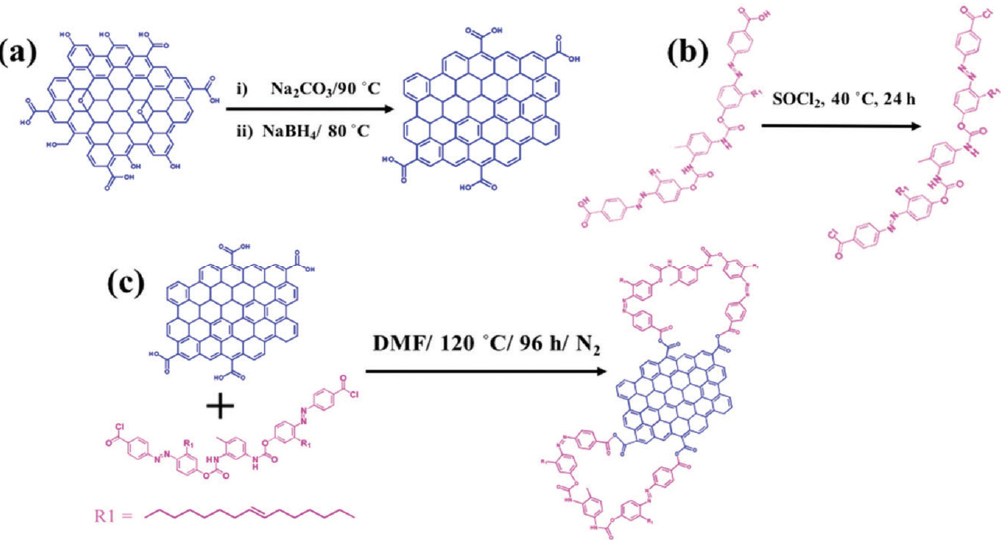
Figure 16. ( a ) Preparation of RGO, ( b ) conversion of AZOC2 to acid chloride, and ( c ) synthesis of the covalent RGO–AZOC2 hybrid (RGO–AZOC2-C). (Reprinted from [116]; published by The Royal Society of Chemistry).